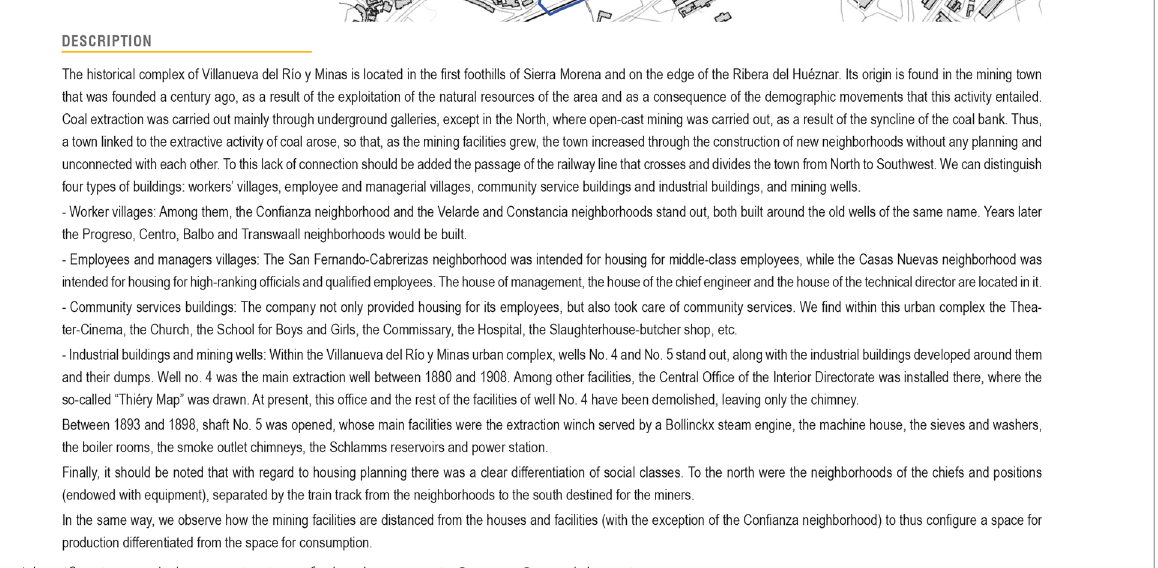
Fig. 5 Identification and characterization of a landscape unit. Source: Own